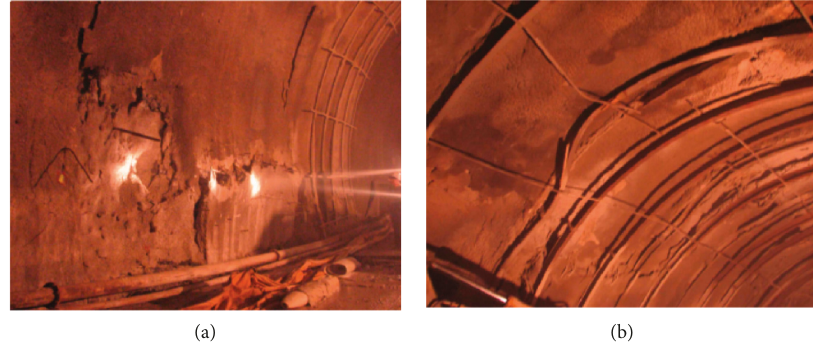
Figure 9: Damage of the initial support of the tunnel. (a) Cracking of the left arch foot. (b) Cracking of the sprayed concrete at the right arch shoulder and deformation of the arch.